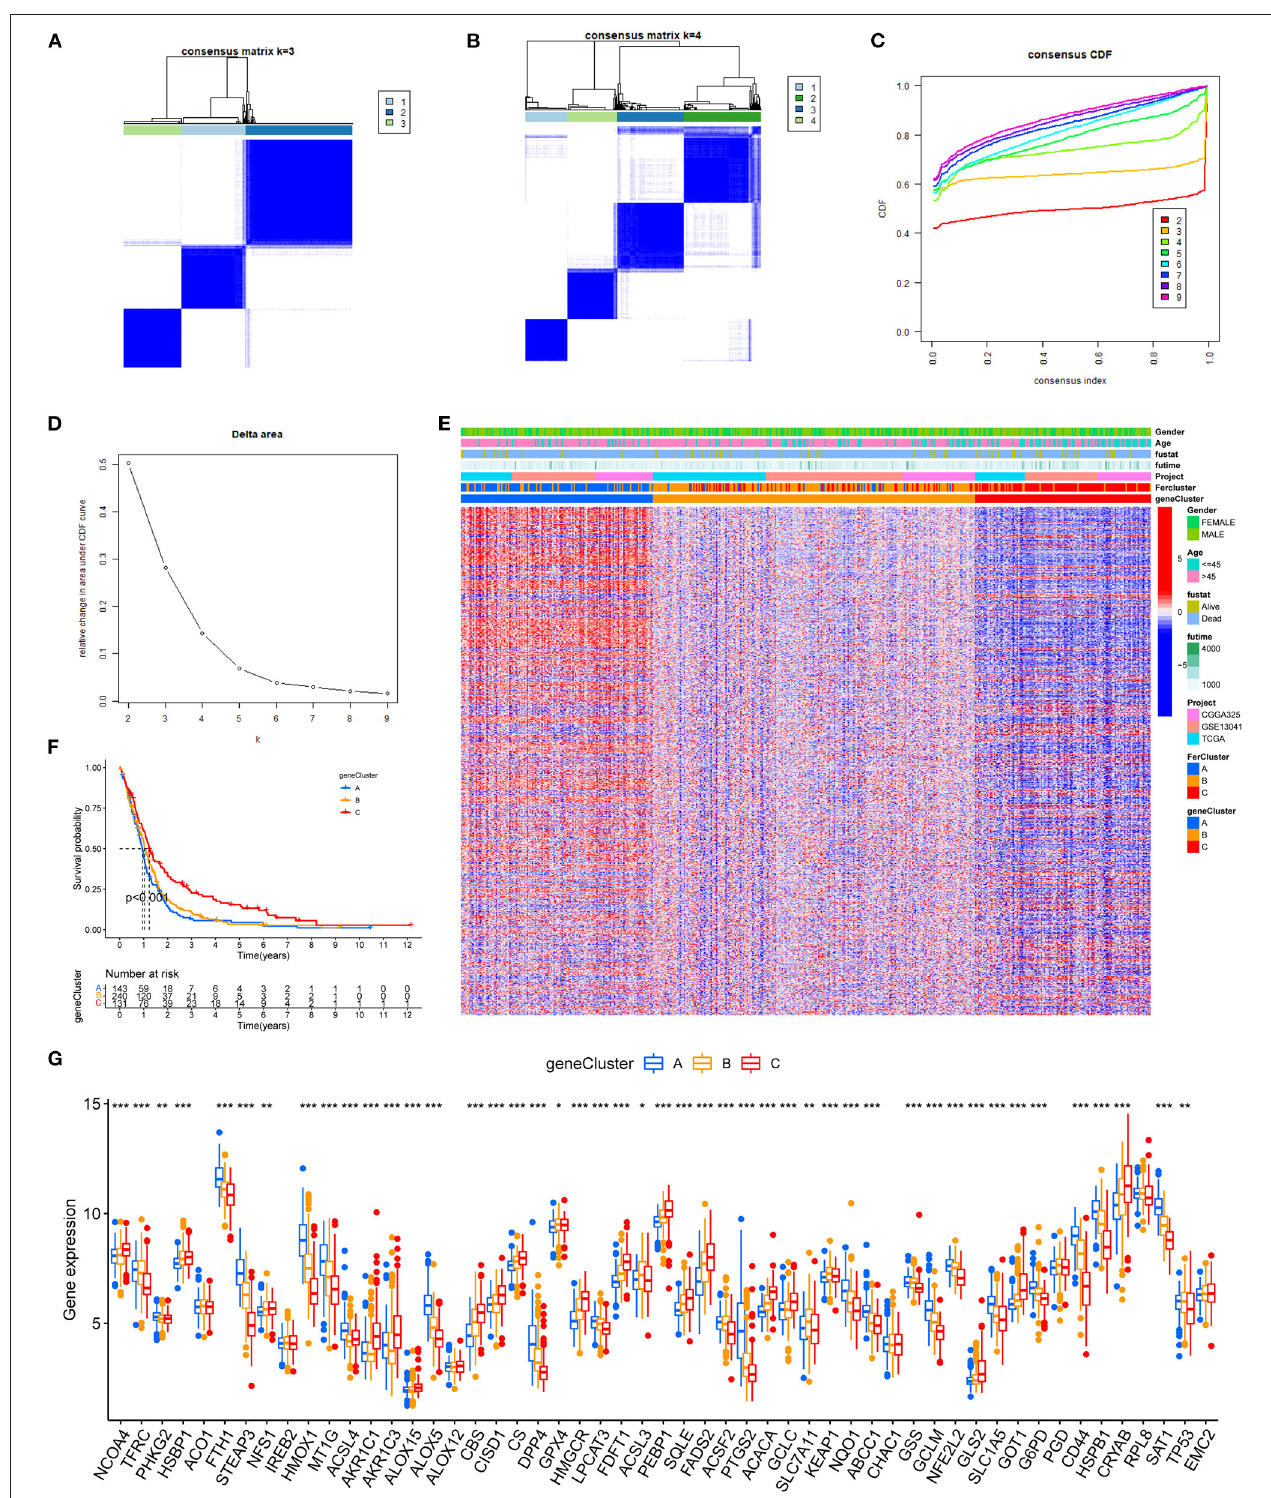
FIGURE 6 | Hierarchical cluster analysis of DEGs. (A–D) The consensus clustering matrix for k = 3 was determined by CDF for k = 2–9. (E) Prognostic differences between the three clusters after merging survival information ( p < 0.01). (F) The heatmap of three clusters and their clinical characteristics. (G) The expression levels of FRGs in different clusters (* p < 0.05, ** p < 0.01, *** p < 0.001).